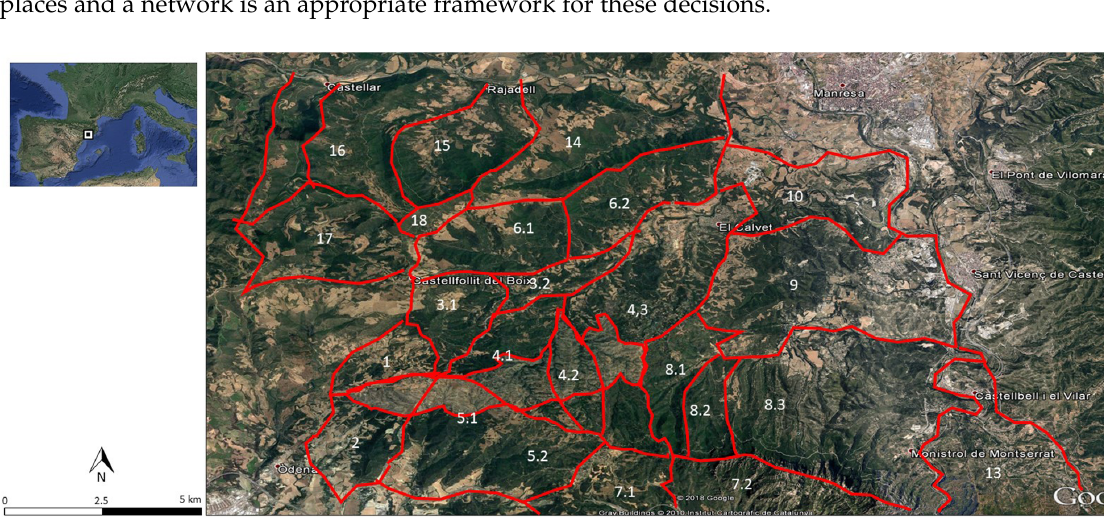
Figure 1. Segmentation of the area of interest to identify tactical objectives